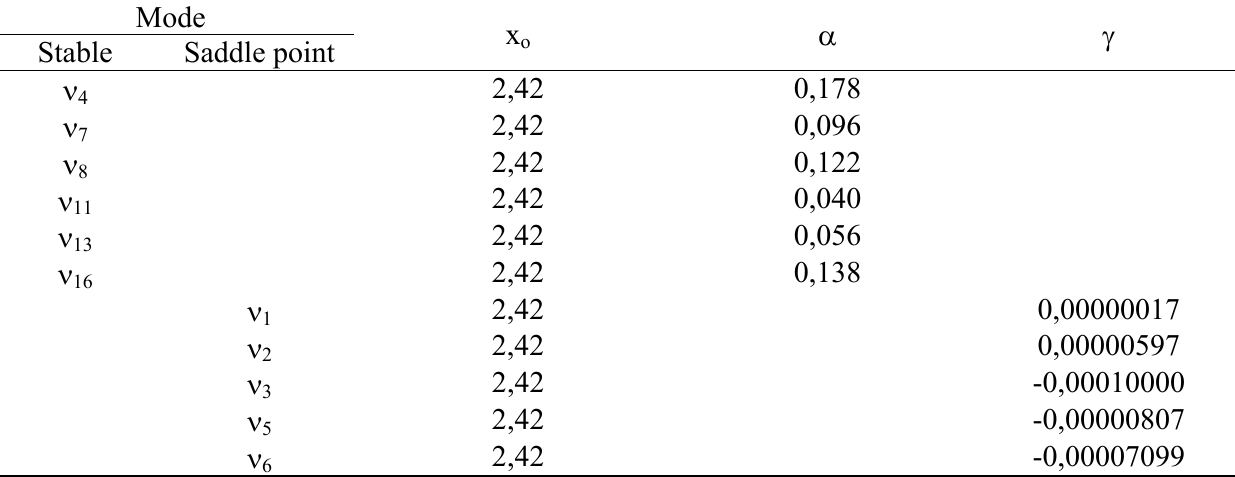
Table 4. Parameters of the two-dimensional